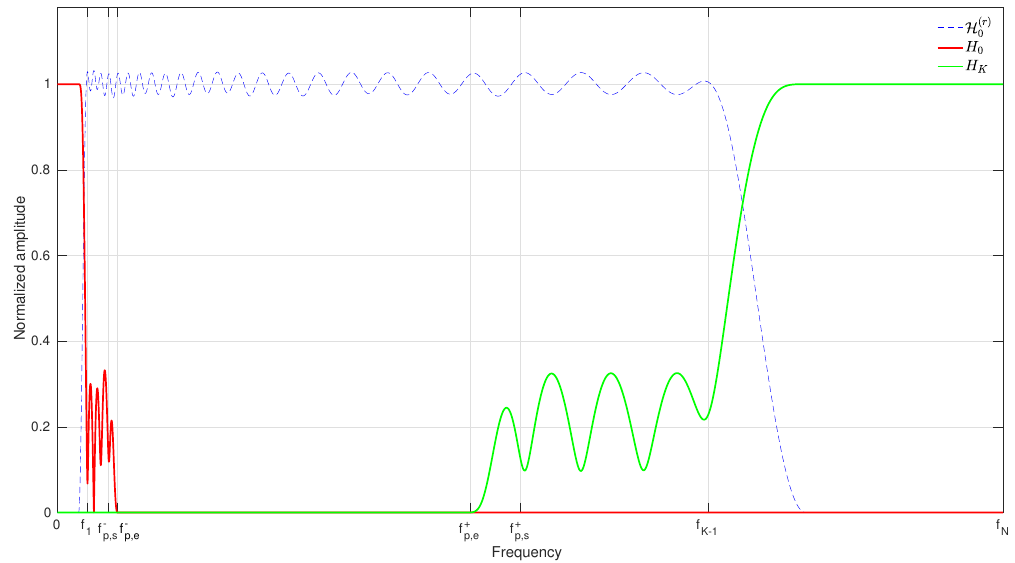
Figure 4. Illustration of the frequency allocations of the filters H 0 (red line) and H K (green line) given the restricted frequency response H